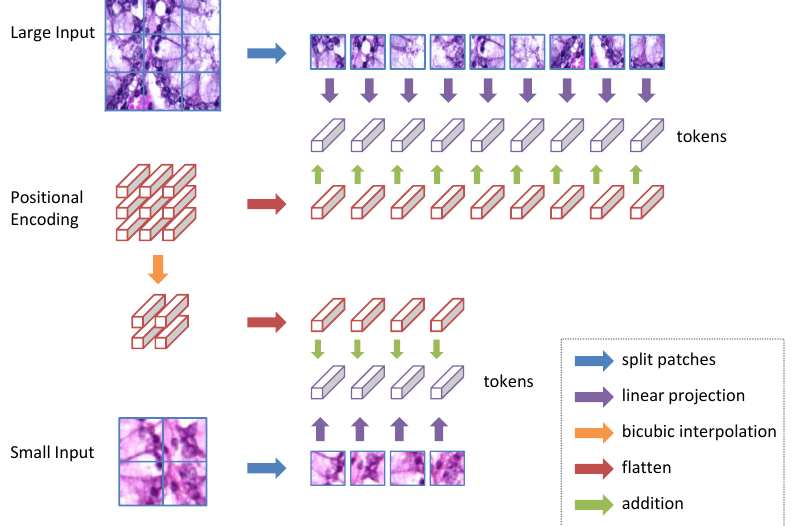
Figure 3. Vision transformers split input images into non-overlapping patches and use linear pro- jection to convert these patches into a 1-dim token sequence. To handle variable input sizes, we interpolate the positional encoding to match the number of tokens. The flattened positional encodings are then added to the token